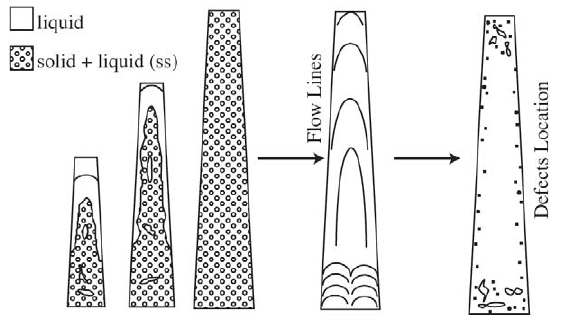
Figure 11. Summary of the material flow and solid/liquid distri- bution during mould